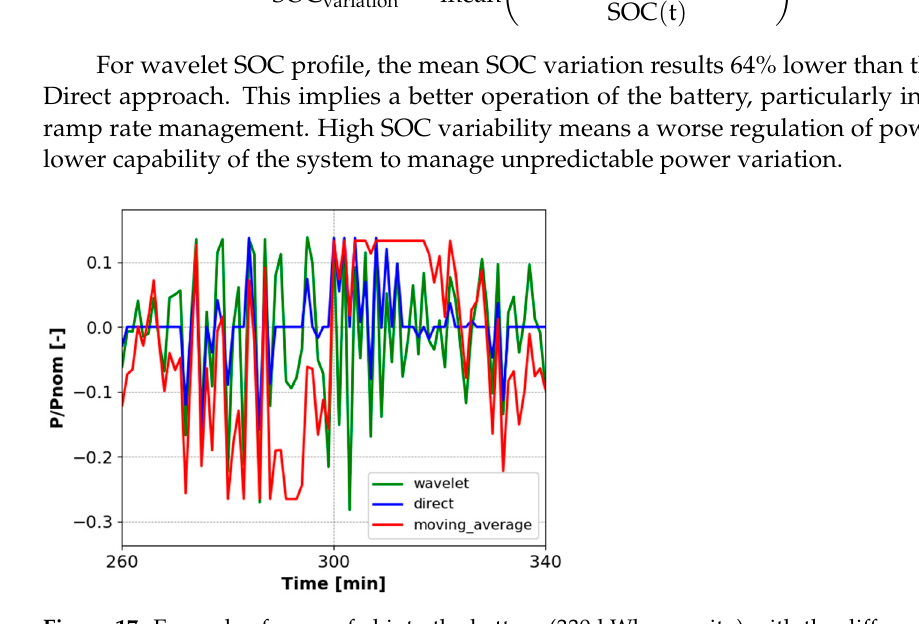
Figure 17. Example of power fed into the battery (330 kWh capacity) with the different methods considered in case the battery energy storage system (BESS) operational constraints are accounted for.